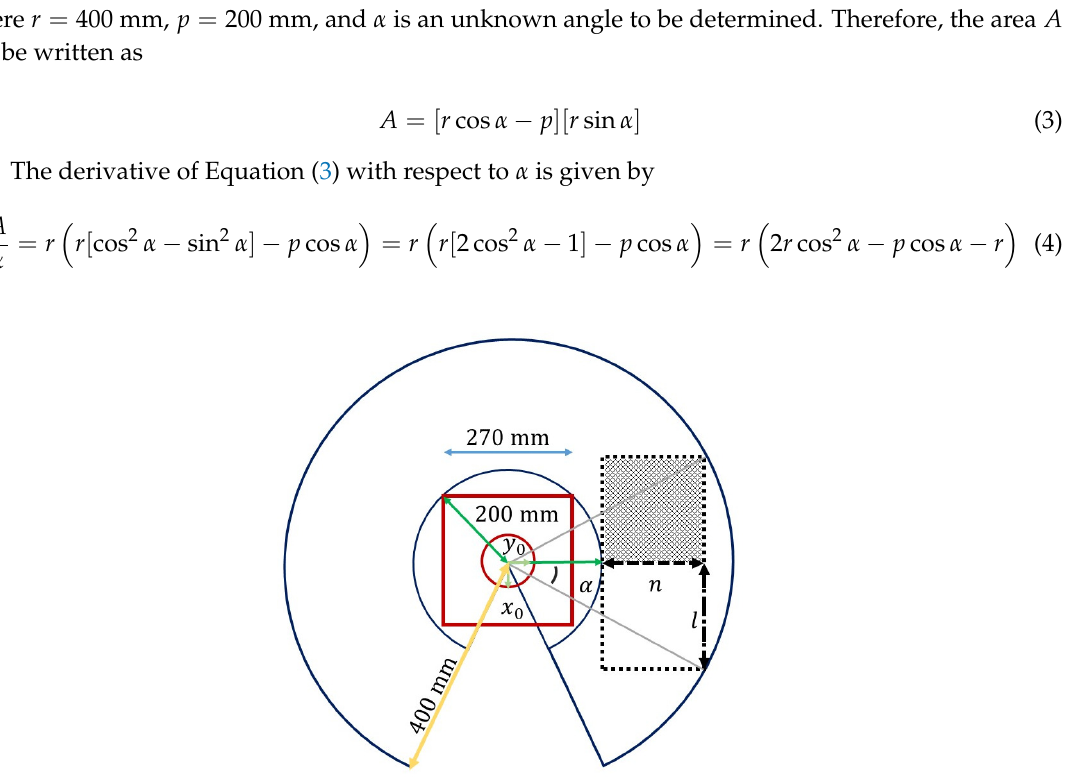
Figure 4. Arm movement